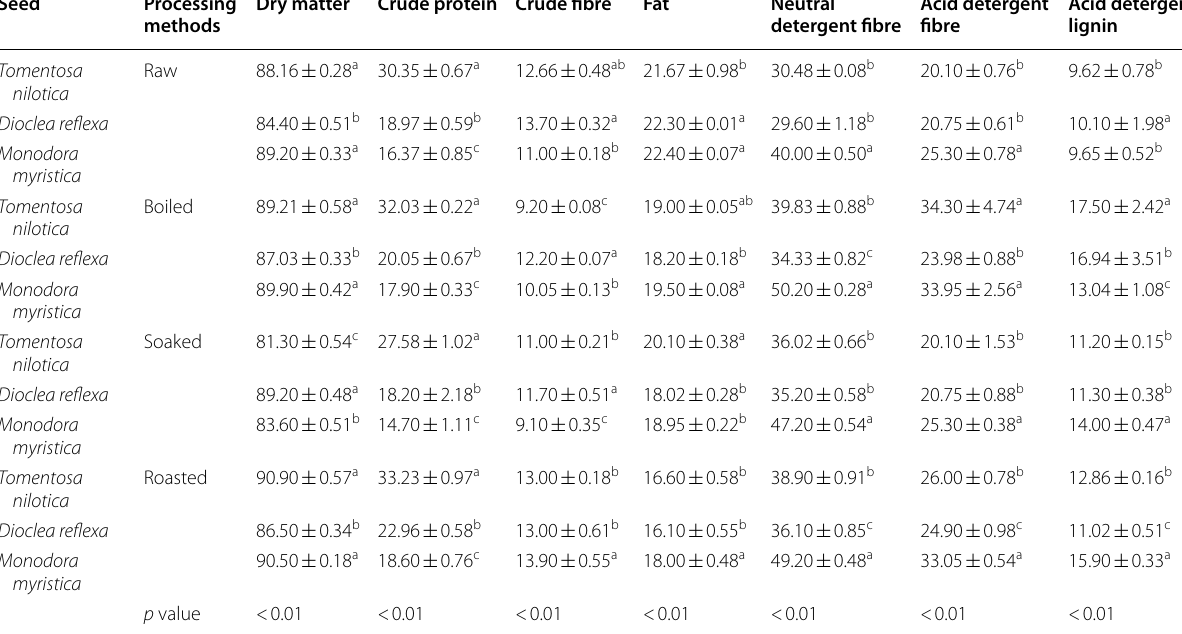
a ,b,c Means within the same row with different superscripts are significantly ( p < 0.05) different. n